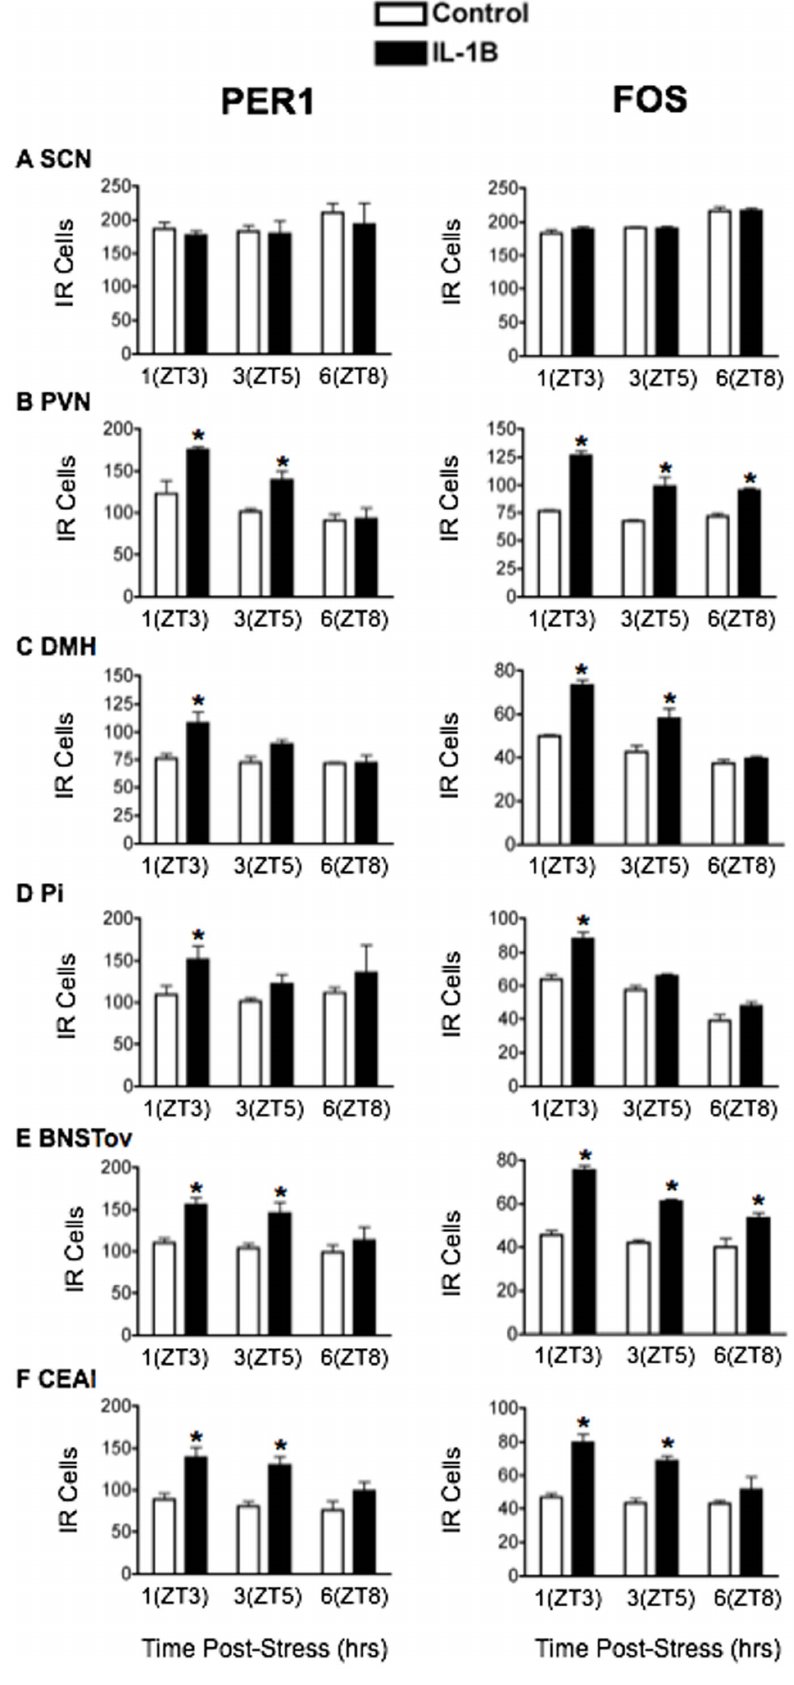
Figure 5. The effect of acute IL-1 b (5 m g/kg) treatment on PER1 and FOS expression. Means 6 SEM of immunoreactive (IR) cells are shown, n =4 per group; * significant difference from corresponding control group, p , 0.05. doi:10.1371/journal.pone.0111166.g005 PLOS ONE |